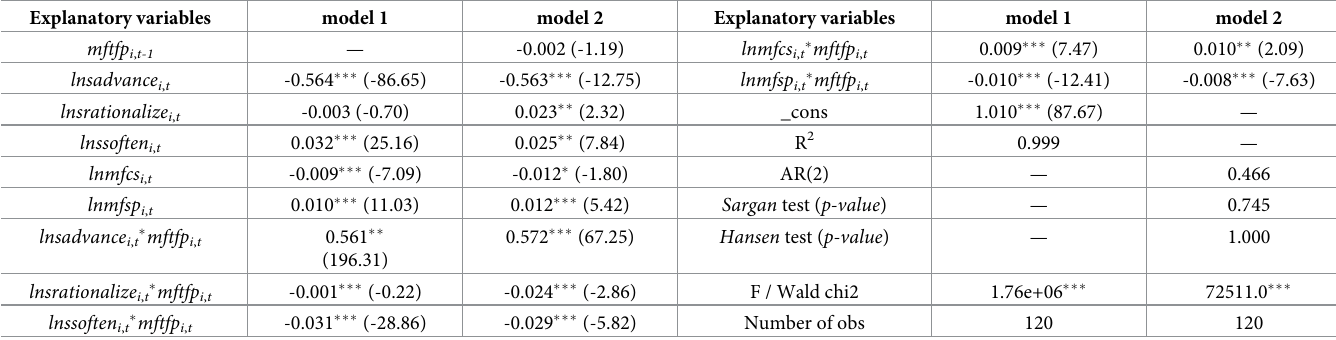
Table 3. Regression results of the impact of changes in marine fishery industrial structure on its total factor